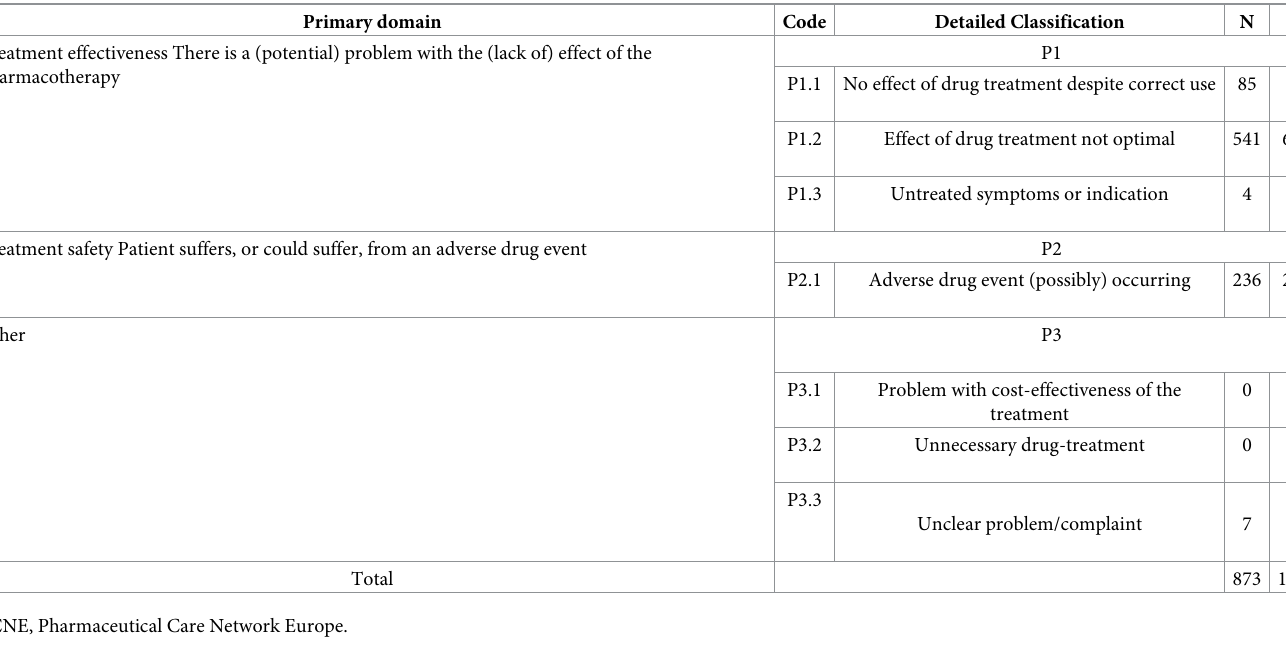
Table 2. Profile of identified Drug-Related Problems (DRPs) according to the Pharmaceutical Care Network Europe (PCNE) V9.00 classification.